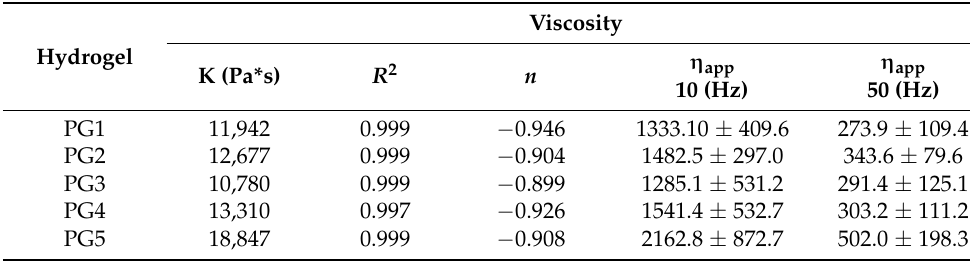
Table 3. Summary of power law parameters for the relationship between storage modulus or viscosity and frequency (0.03 < ω < 70.00 Hz or at 10 and 50 Hz) of pectin hydrogels